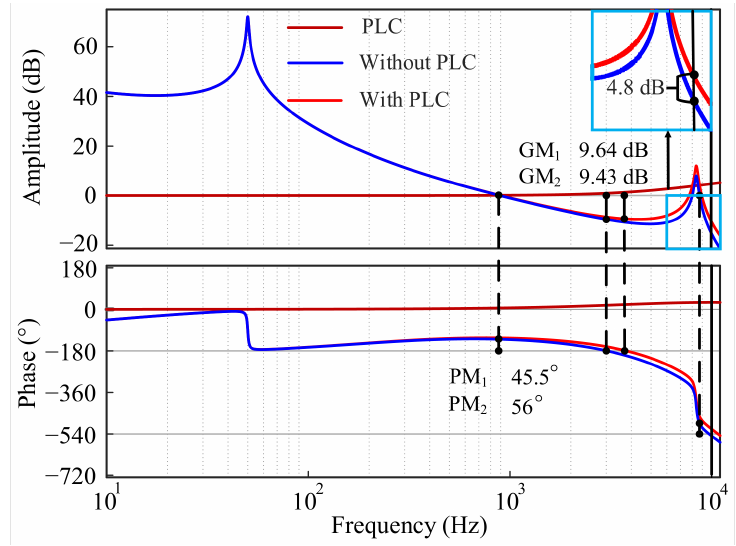
Figure 15. Bode plots of the PLC and the open-loop transfer functions before and after using the PLC